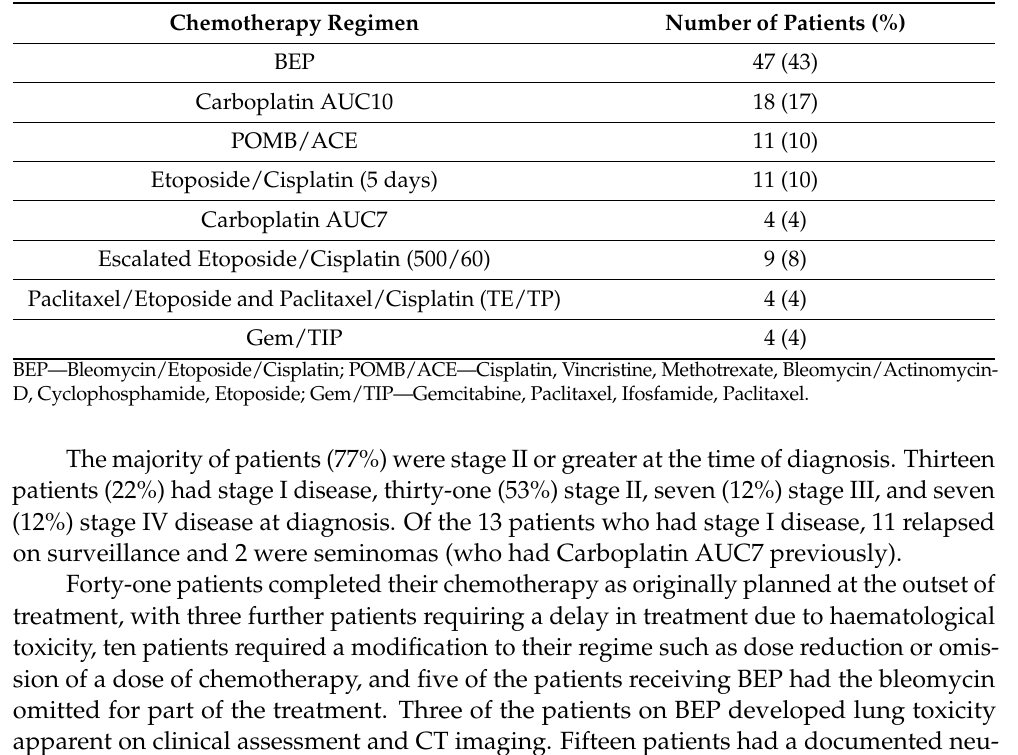
Table 2. Chemotherapy regimens used in testicular germ cell patients.